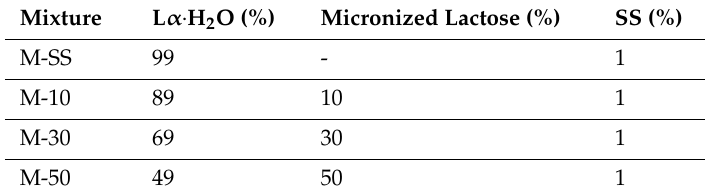
Table 2. Composition (% w / w ) of the studied ternary mixtures of α -lactose monohydrate (L α · H 2 O), salbutamol sulphate (SS), and variable percentages (from 10% to 50%) of micronized lactose in comparison with a binary mixture containing no micronized lactose (M-SS).